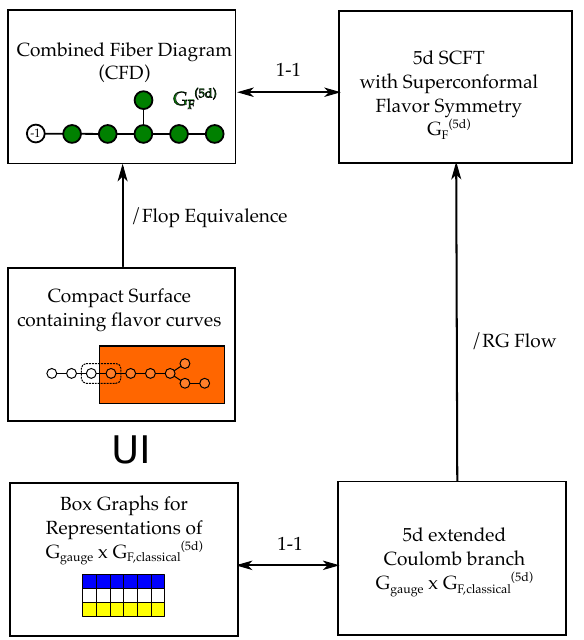
Figure 2 . This diagram shows schematically the approaches taken in the present paper and in the companion paper [31], where box graphs and Coulomb branch phases will be discussed. The CFDs were initially introduced in [8] and encode (among other things) the strongly-coupled (cid:13)avor symmetry G (5 d )